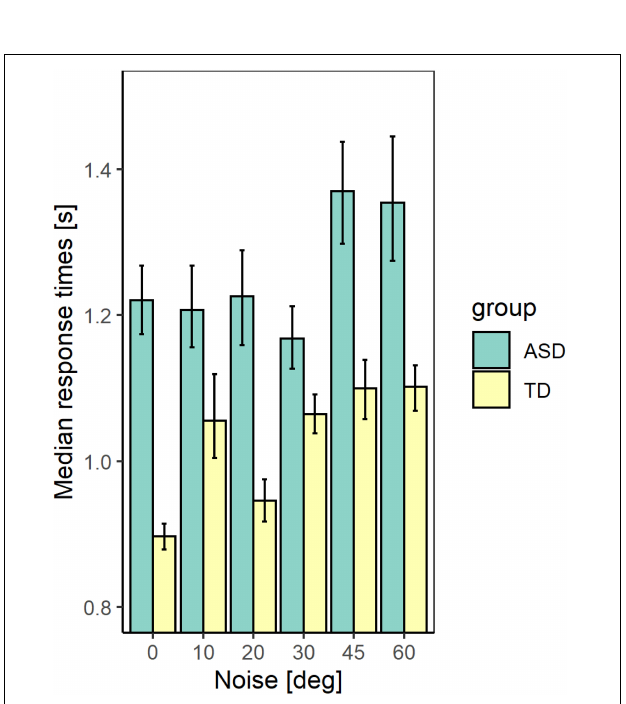
FIGURE 5 | The median values of the response time for the two groups with different development at different noise levels. The error bars correspond to the 2.5 and 97.5% values of a bootstrap sample of size